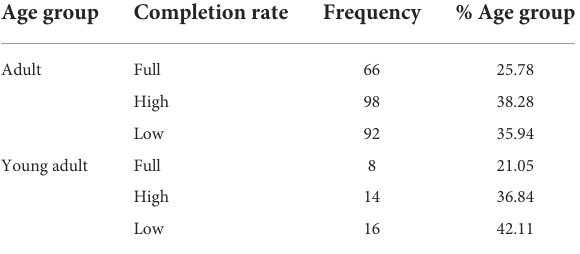
TABLE 2 Overview of completion rate frequencies by age